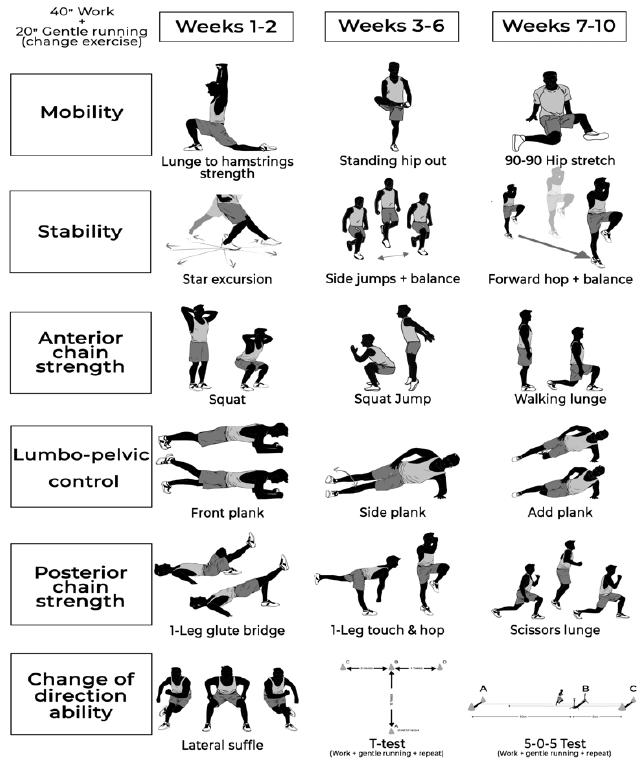
Figure 4. Neuromuscular training protocol.